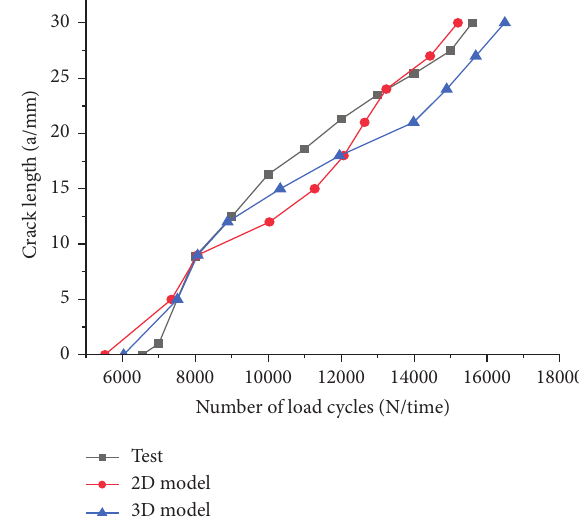
Figure 8: Crack propagation curves based on the macromolecule polymer crack paste